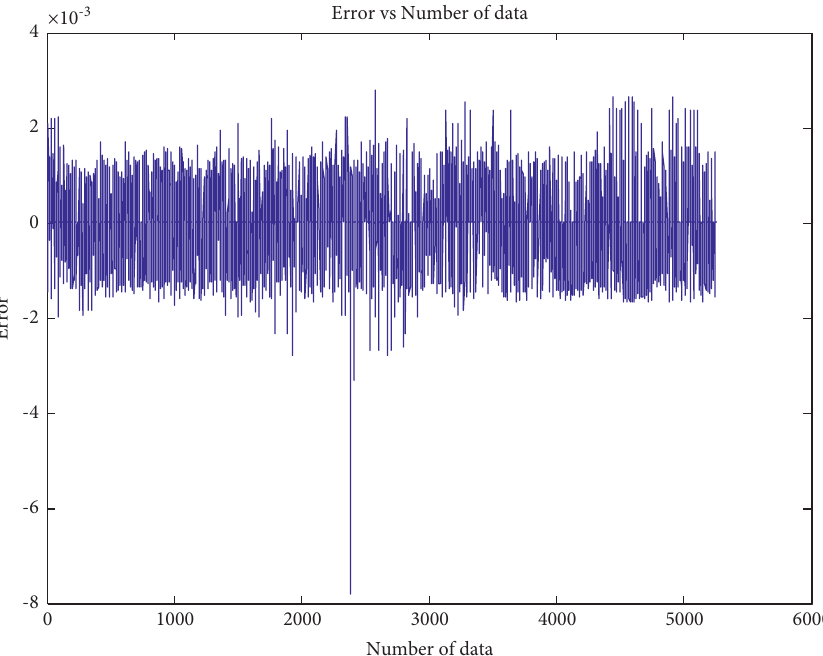
Figure 8: Error vs. the number of data.